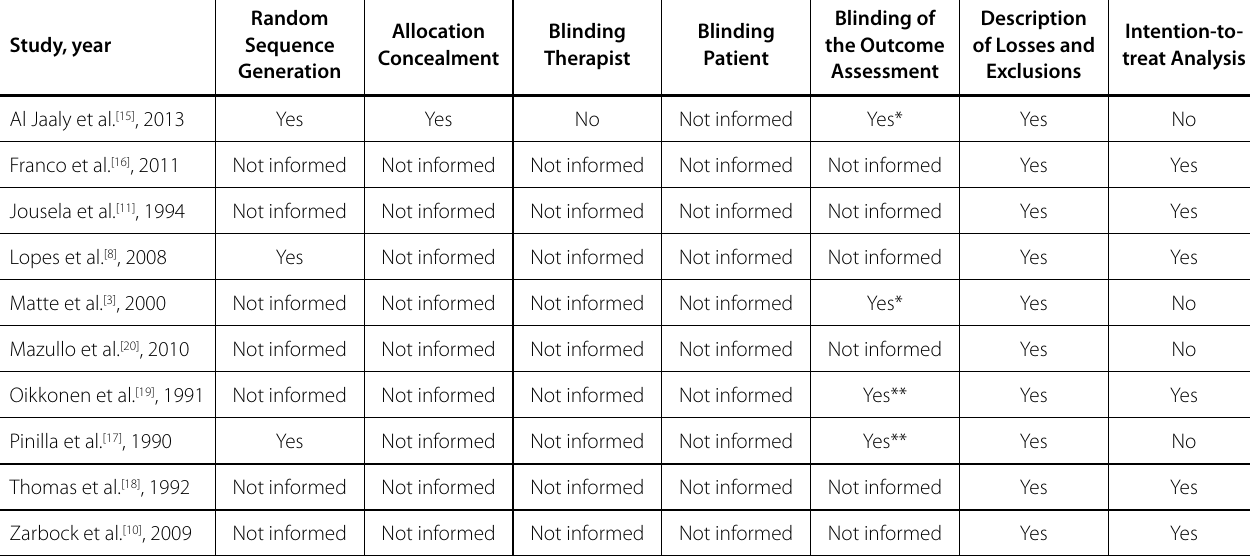
Table 3. Risk of bias assessment. Study, year